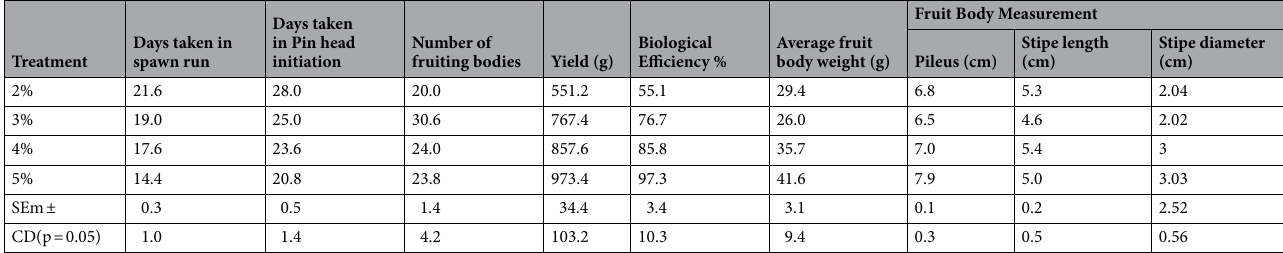
Table 3. Effect of varied quantity spawn rates on spawn run, pinhead initiation, yield and morphology of Pleurotus eryngii. SEm ± : Standard error of the mean. CD (p = 0.05) : Critical difference. All the observations are average of five